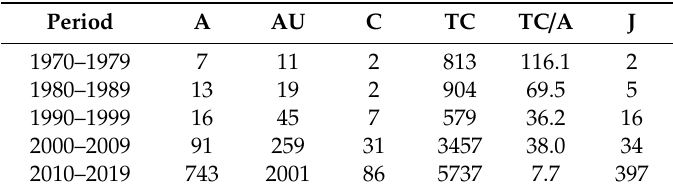
Table 3. Major characteristics of the articles